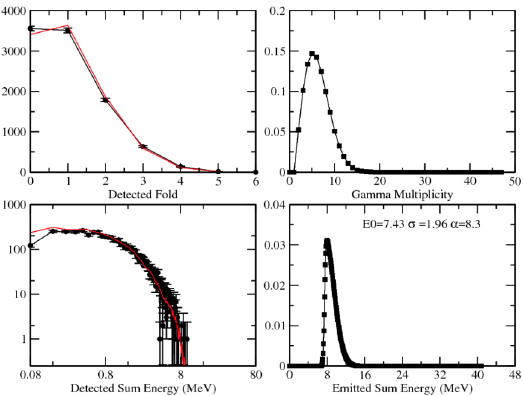
Figure 7: Distributions of multiplicity and total energy for γ emission in 235 U(n,f). Left column: raw data (black) and result of a modelling (red). Right column: distributions after e ffi ciency correction [10].